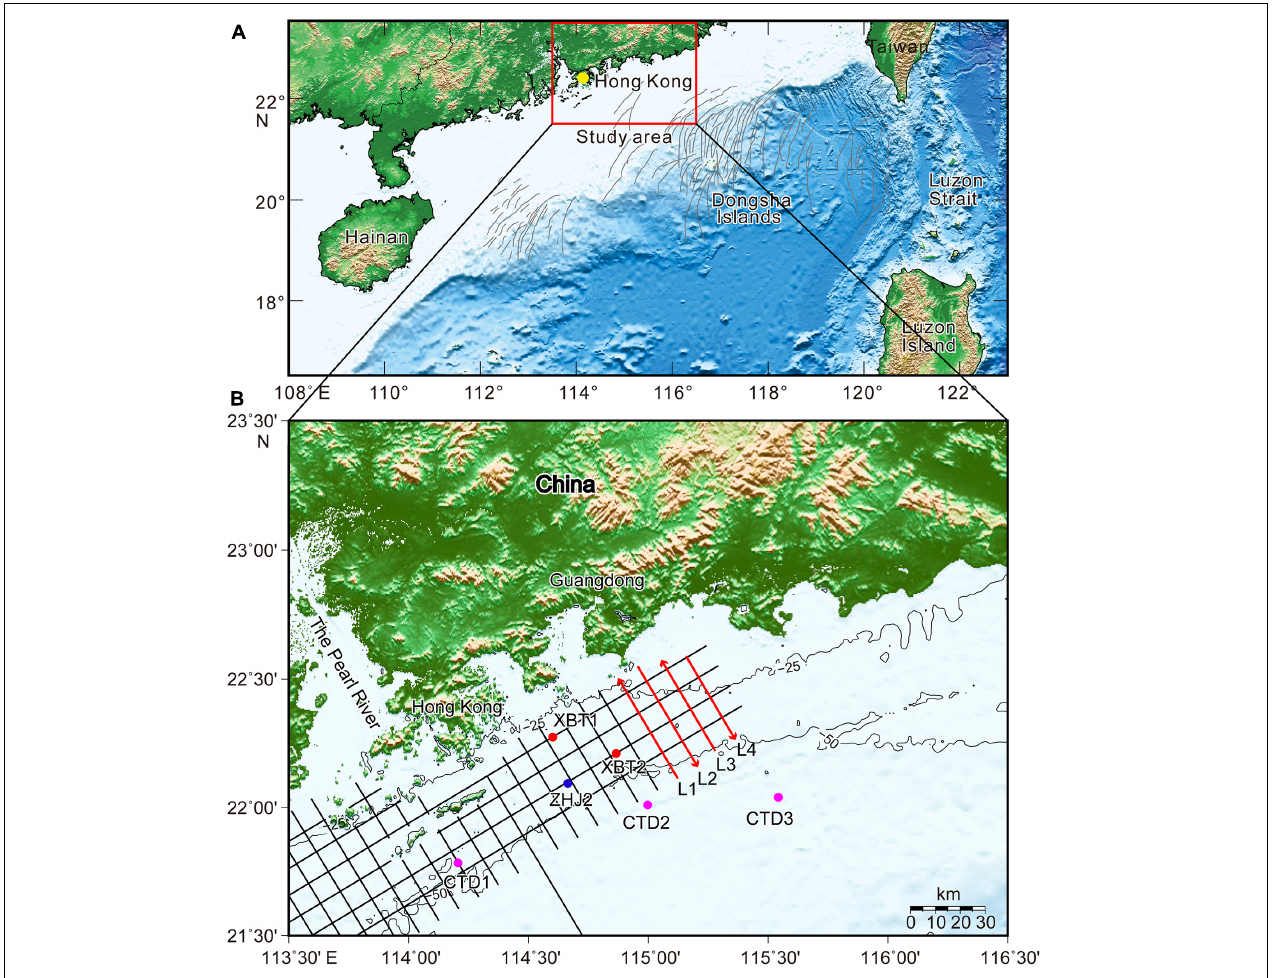
FIGURE 1 | Bathymetry of the northern South China Sea (A) and shallow water offshore of Guangdong (B) . Gray curves are the satellite-imaged ISWs modified from Zhao et al. (2004) and Li et al. (2011). The black and red lines denote the acoustic backscatter survey lines acquired in July 2020. The red arrows indicate the directions of the survey lines. The solid circles show the locations of two XBT sites (red), CTD stations (magenta, Chen et al., 2017), and taut-line mooring station ZHJ2 (blue, Lee et al., 2021).